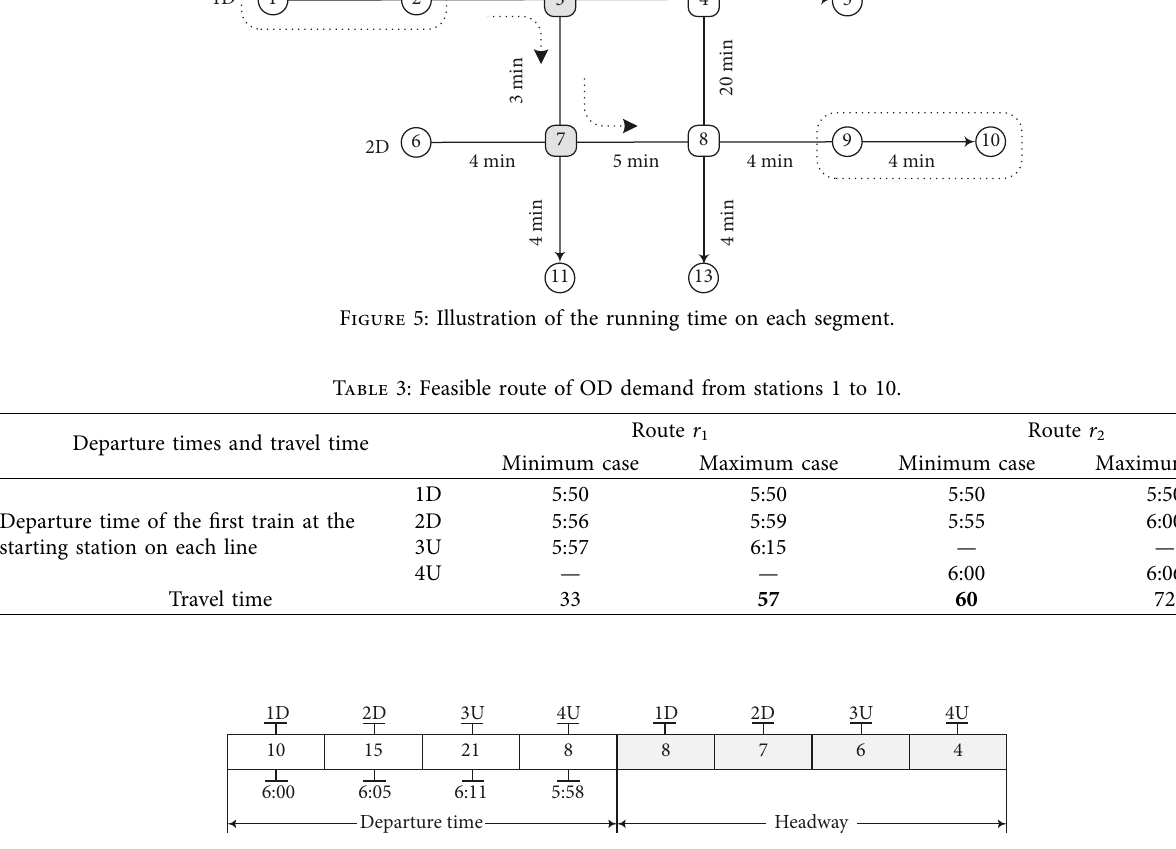
Figure 6: Chromosome structure for four